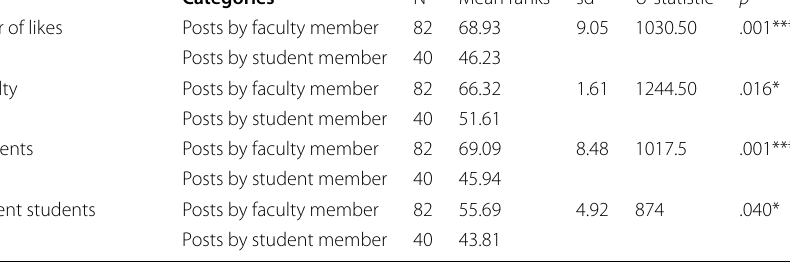
*Significant at p < .05 level **Significant at p < .01 level ***Highly significant at p < .001 level All results are for a 95% confidence